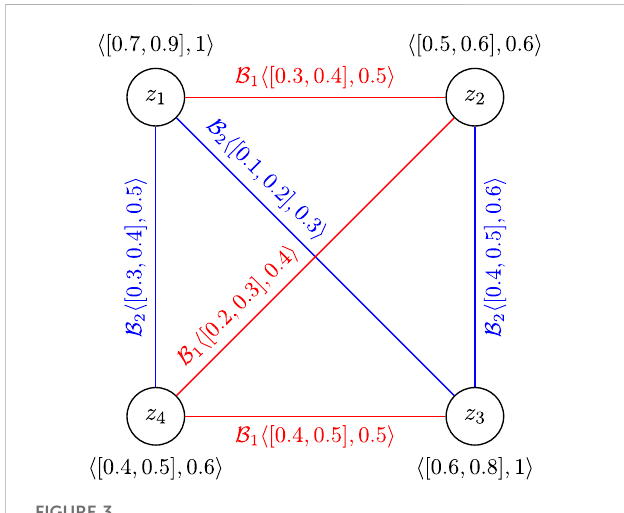
FIGURE 3 The 〈 [1, 1.3], 1.5 〉 - B 1 -total vertex regular CFGS, G (cid:2) ( A , B 1 , B 2 )